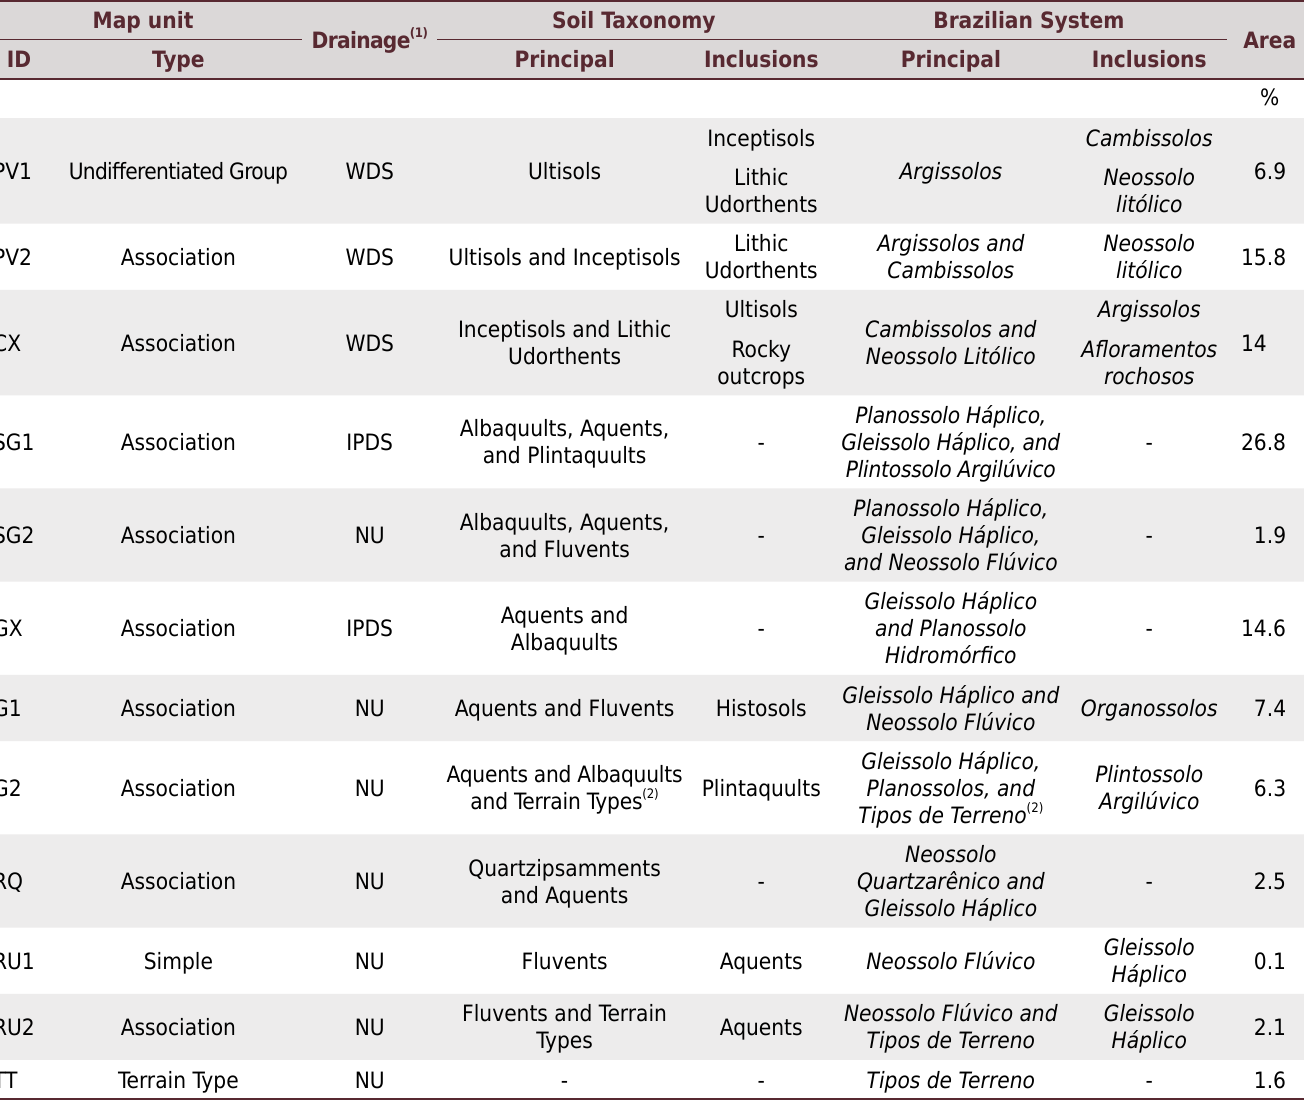
Table 1. Soil map units in the Soil Survey map of Porto Alegre, RS, Brazil (adapted from Schneider et al., 2008) Map